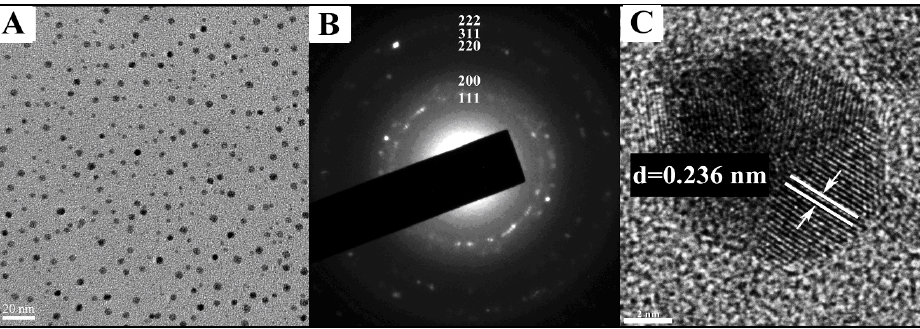
Figure 5. XRD pattern of PFcMAss-functionalized AuNPs ( A ) and GO-PFcMAss-AuNPs ( B ).